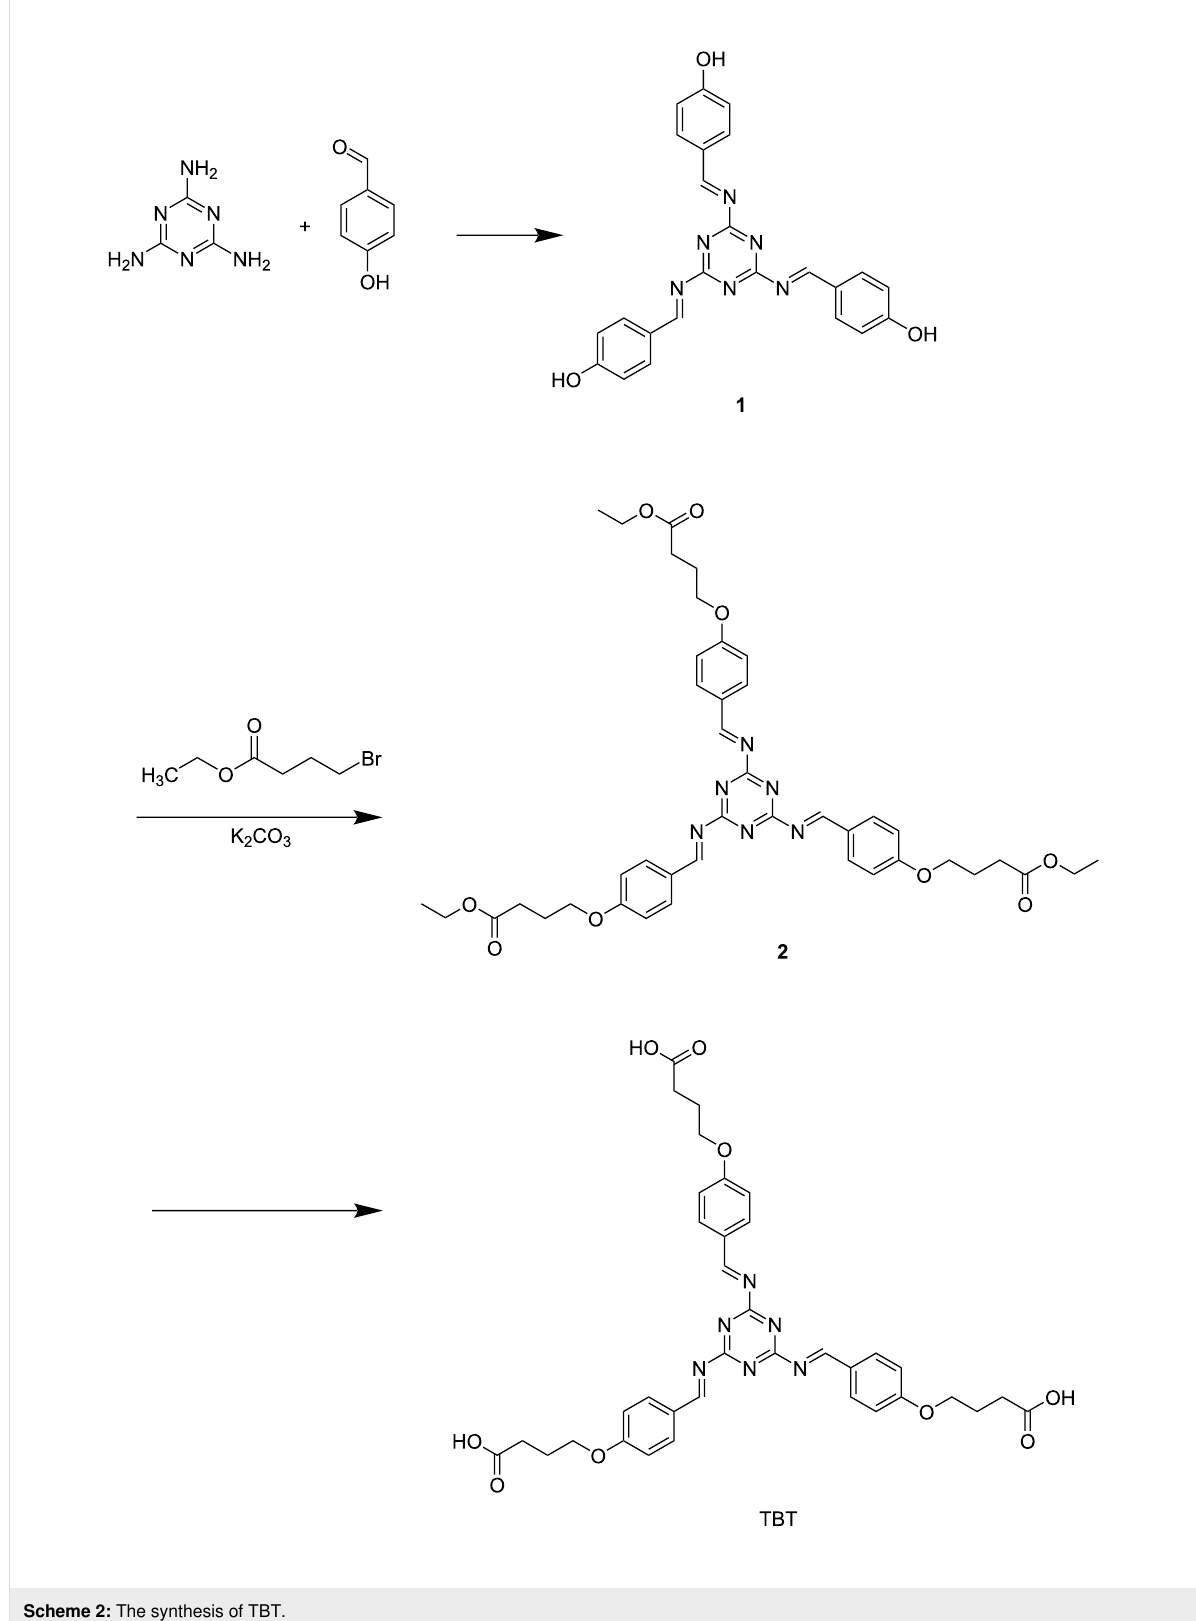
Scheme 2: The synthesis of